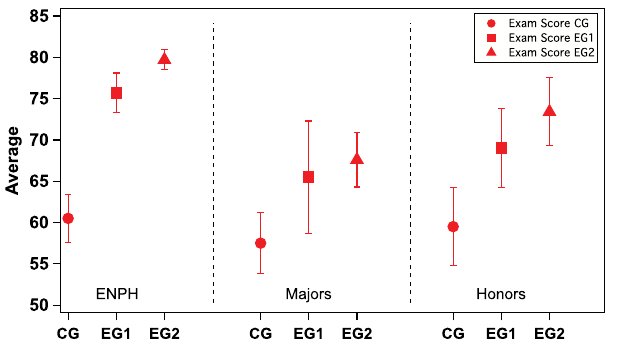
FIG. 1. Normalized exam score average of the engineering physics, physics majors, and physics honors students in the control (lecture-based) group, CG and experiment groups (trans- formed), EG1 and EG2. Error bars shown on the exam scores are the standard error.